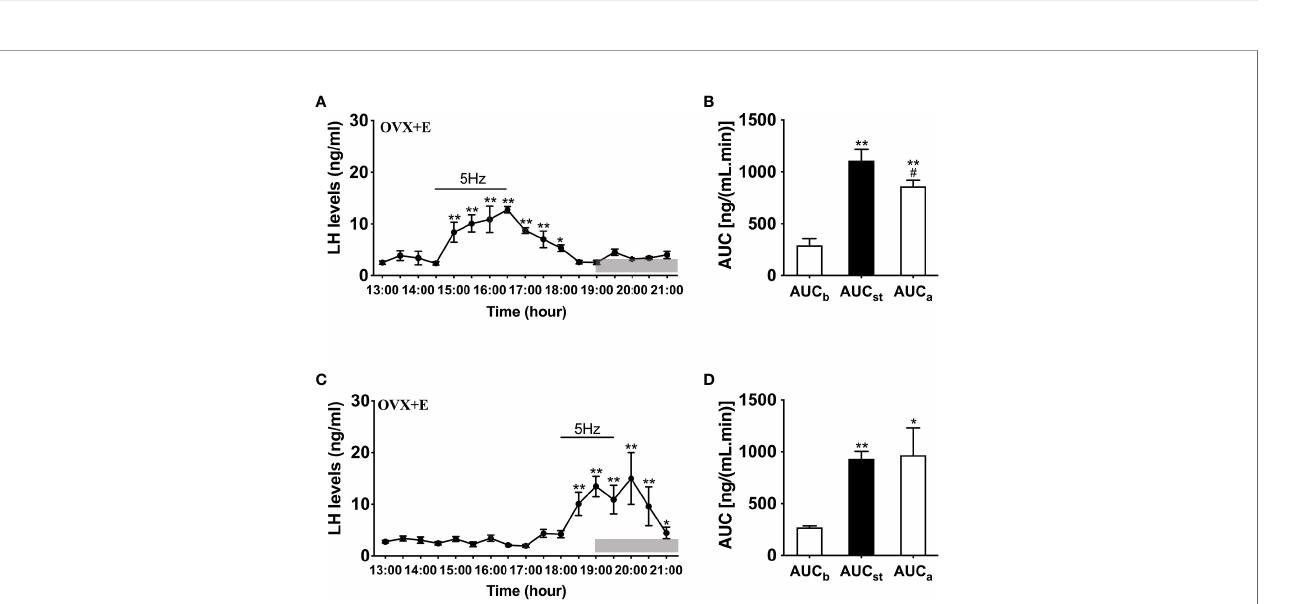
FIGURE 4 | Effects of optogenetic activation of ARC kisspeptin neurons on LH secretion in OVX estradiol capsule implanted Kiss-cre mice. (A) Evoked LH secretion (Mean ± SEM) in response to 5 Hz blue-light stimulations of ARC kisspeptin neurons (14:30 - 16:30 h) in Kiss-cre OVX mice implanted with estradiol capsules (OVX+E) (n = 5). (B) Area under curve of LH levels before (AUC b , 13:00 - 14:00 h), during (AUC st , 14:30 - 16:30 h) and after optic stimulation (AUC a , 16:30 - 18:30 h). (C) Evoked LH secretion in response to 5 Hz optic stimulations of ARC kisspeptin neuron (18:00 -19:30 h) Kiss-Cre OVX+E mice (n = 4). (D) Area under curve of LH levels before (AUC b , 16:00 - 17:30 h), during (AUC st , 18:00 - 19:30 h) and after stimulation (AUC a , 19:30 - 21:00 h). *P < 0.05 and **P < 0.01 (unpaired t-test) relative to basal LH levels or AUC for basal LH levels. # P < 0.05 indicates a signi fi cant difference relative to AUC for stimulation periods. Lights off is at 19:00 h for all experiments, as indicated by the grey bar on the abscissa.